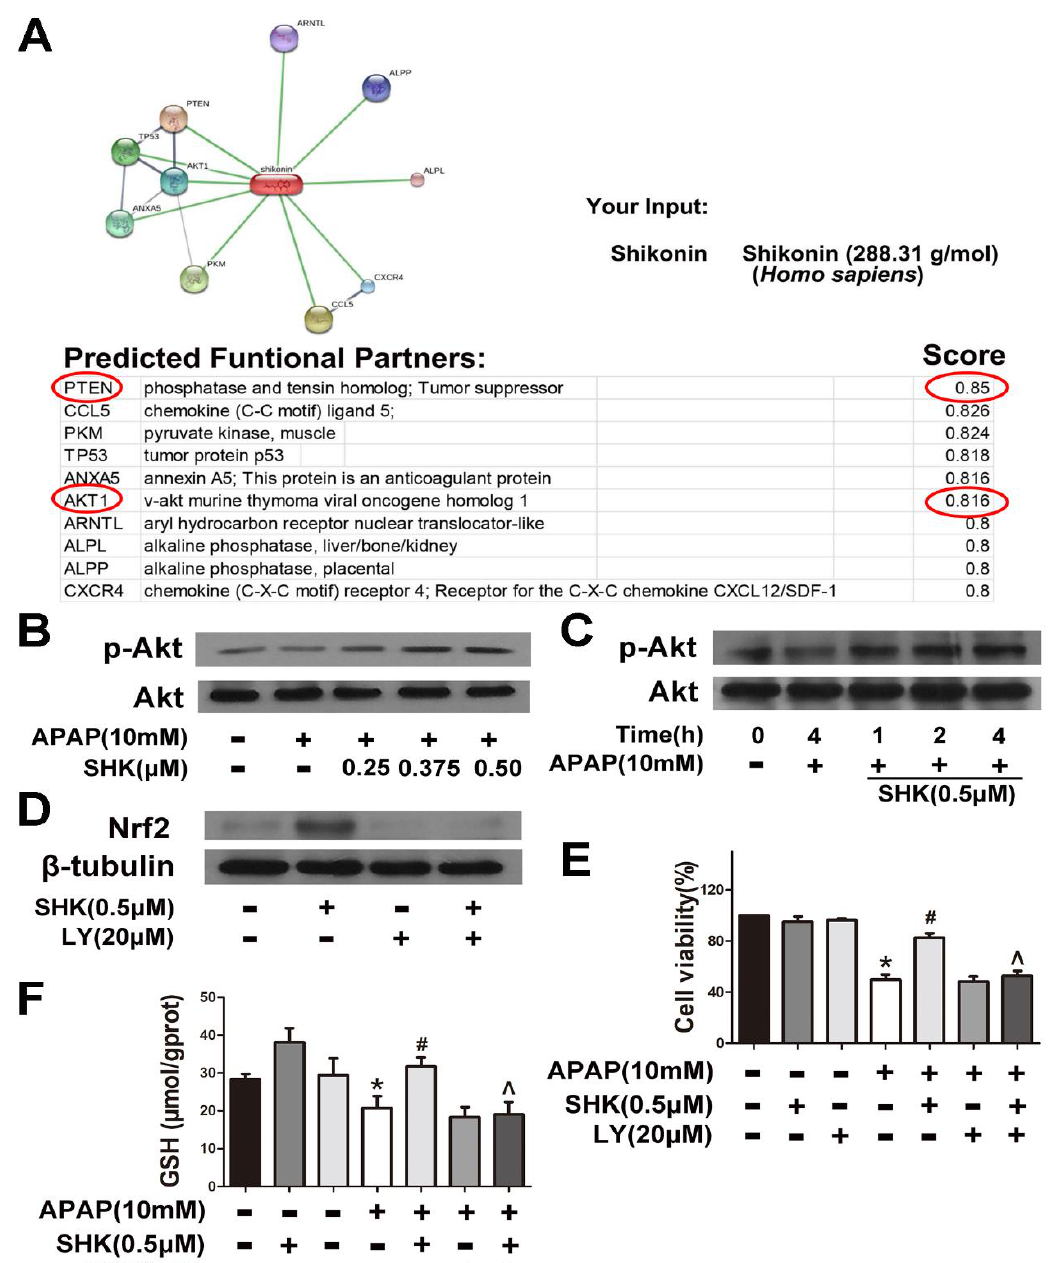
Figure 5. Akt phosphorylation is involved in SHK-mediated protective effects. ( A ) Protein and small molecule/chemical interaction analysis of SHK using STITCH (version 5.0). ( B , C ) L-02 cells were incubated with SHK for the indicated durations, and then the levels of Akt phosphorylation were evaluated by Western blotting. ( D ) L-02 cells were pretreated with LY294002 (20 µ M) for 1 h, followed by treatment with SHK and LY294002 for 8 h, and then the Nrf2 protein levels were evaluated by Western blotting. ( E , F ) Cells were pretreated with LY294002 (20 µ M) for 1 h, followed by treatment with SHK and LY294002 for 1 h, and then the cells were exposed to APAP for 24 h, then cell viability and GSH depletion was assessed. All of the data shown represent the average from three independent experiments. * p < 0.05 versus the control group; # p < 0.05 versus the APAP group; ˆ p < 0.05 versus the SHK plus APAP group.